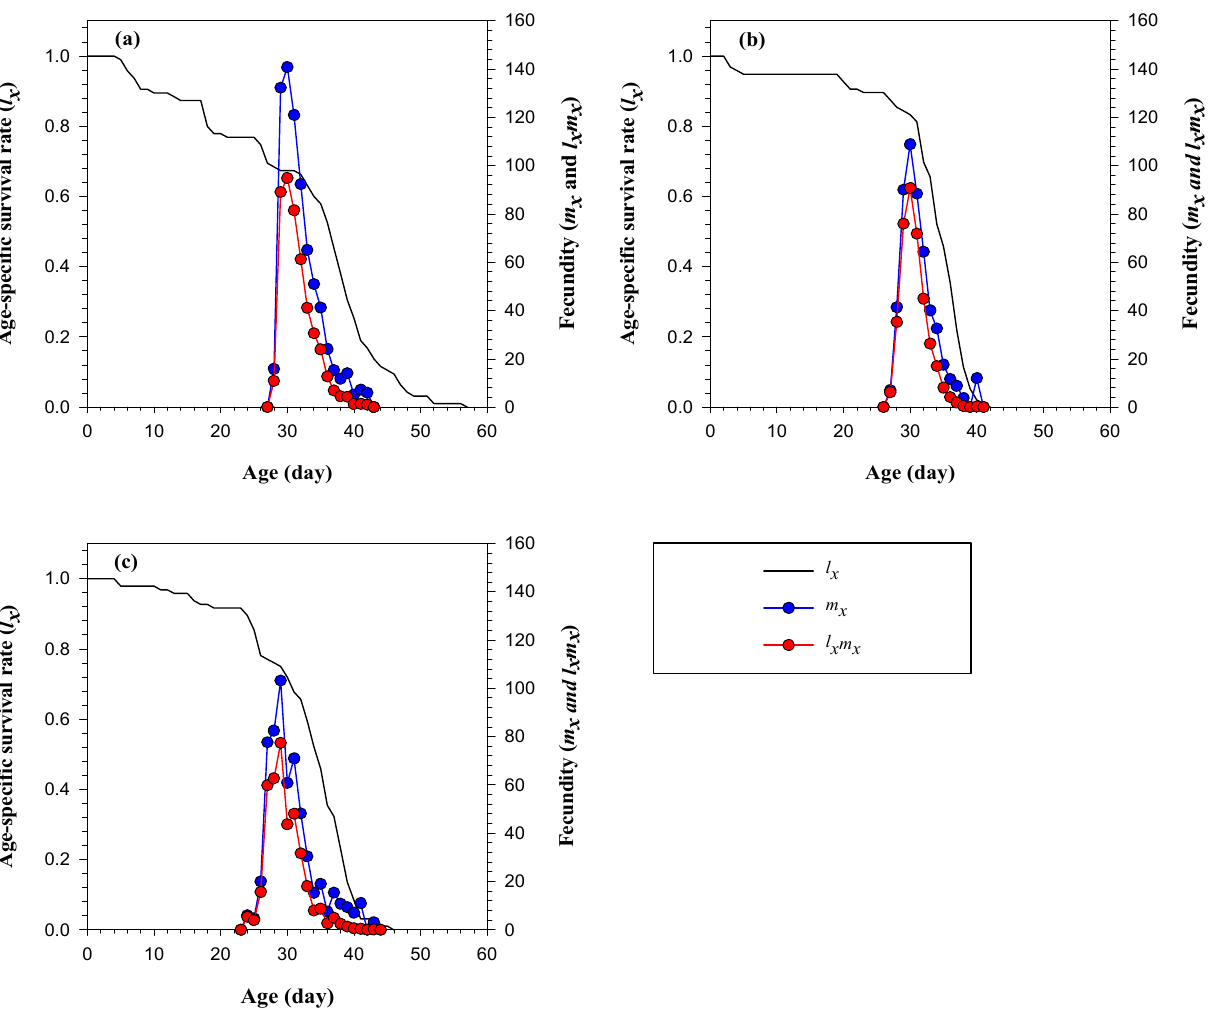
Figure 3. The age-specific survival rate ( l x ), the female age-specific fecundity ( m x ), and age-specific net maternity ( l x m x ) of FAW on ( a ) napier grass, ( b ) natal grass, and ( c ) sunn hemp.